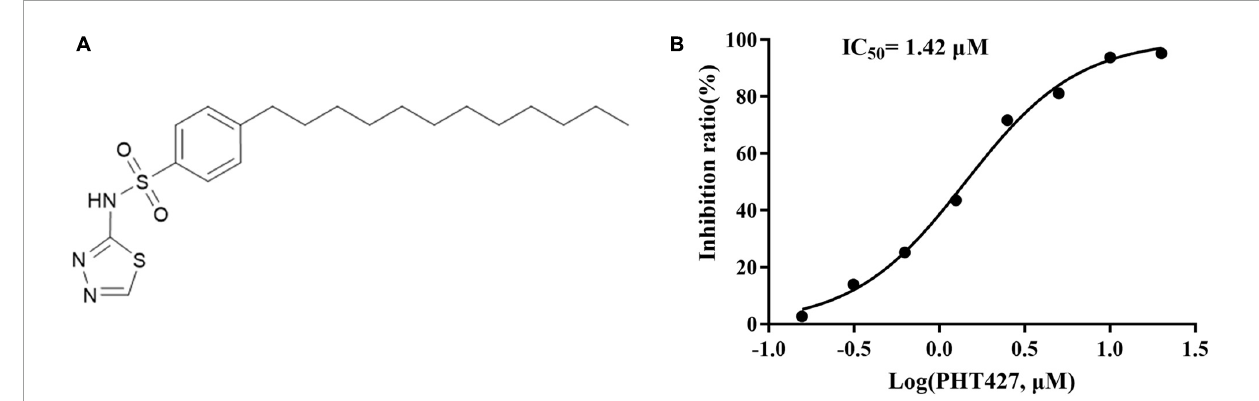
FIGURE1 Identification of PHT427 as an effective NDM-1 inhibitor. (A) The structure of PHT427. (B) Enzyme inhibition assay was used to detect the activity of NDM-1.